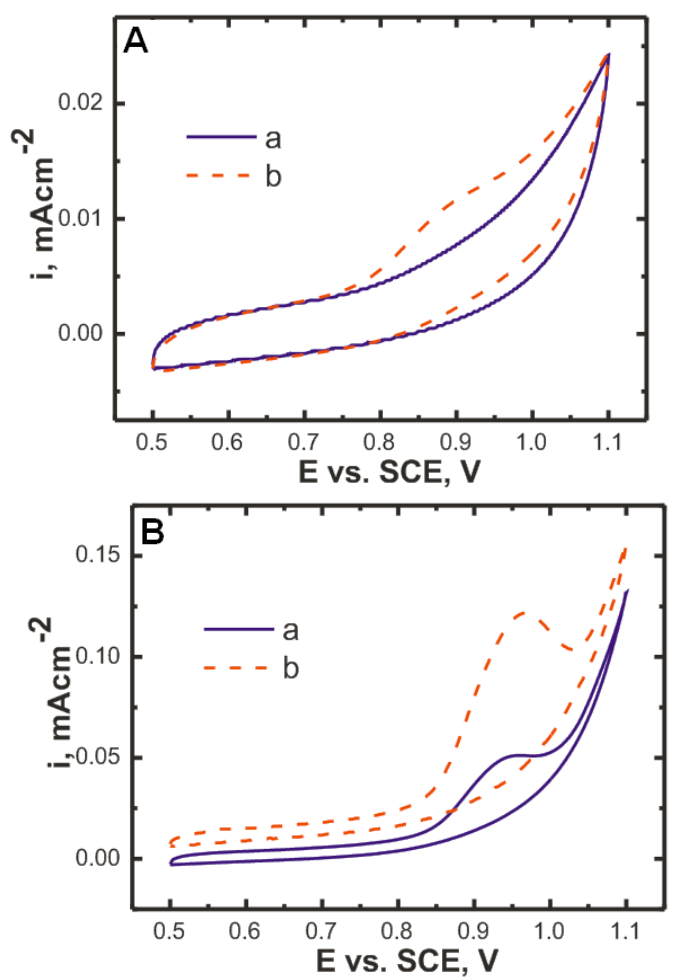
Figure 7. Comparison of cyclic voltammetry responses of the 4-ABA films on GCE (A) and stainless steel (B) deposited by cyclic voltammetry (solid line) or galvanostatically (dashed line). Electrolyte: 0.5 mol dm -3 K